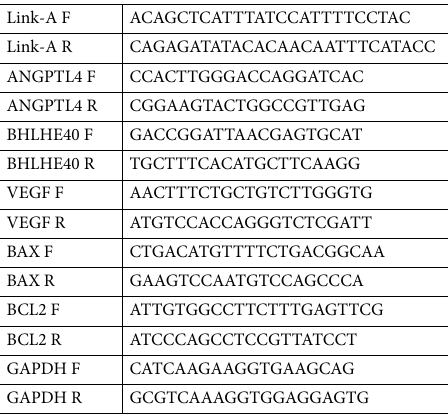
Table 1. Next, thermal cycling was implemented in the Magnetic Induction Cycler system in the specific sched- uled program for each primer pairs.